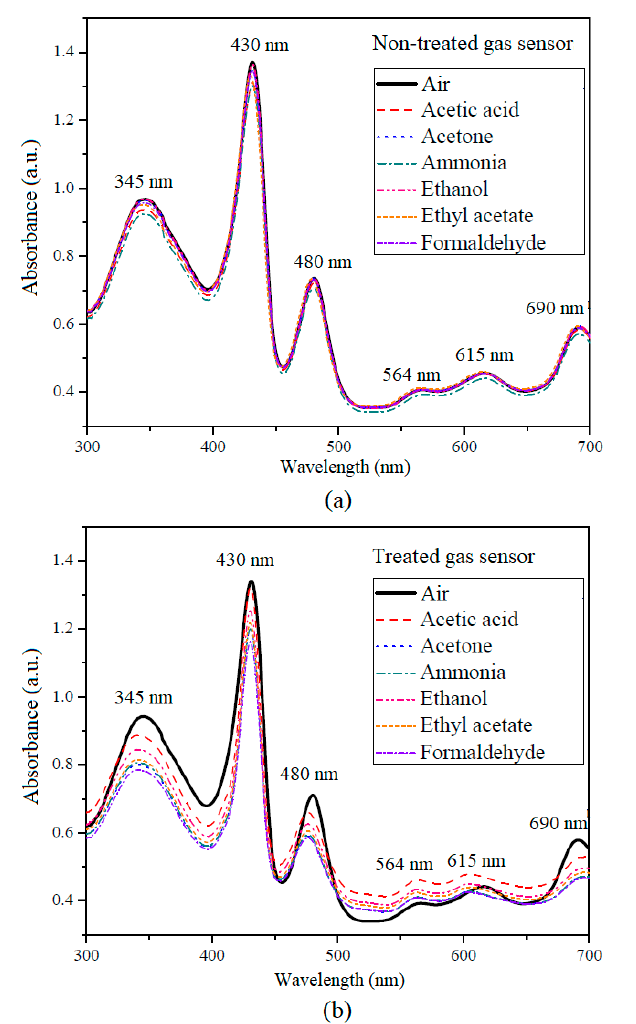
Figure 2. UV-Visible absorption spectra changes of ( a ) non-treated and ( b ) thermally treated gas sensors with volatile organic compound (VOC) exposure.